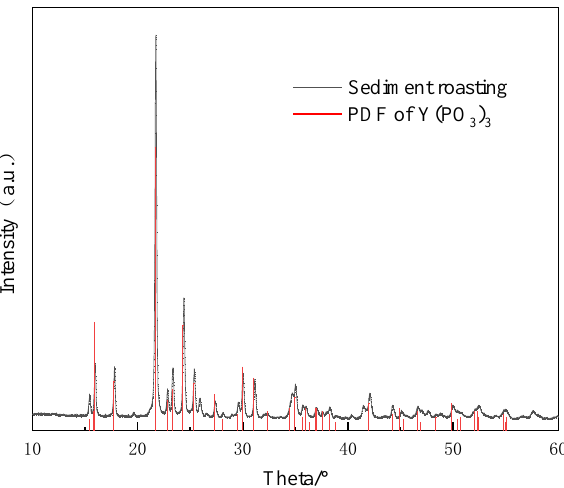
Figure 8. XRD characterization of a complex product after roasting.